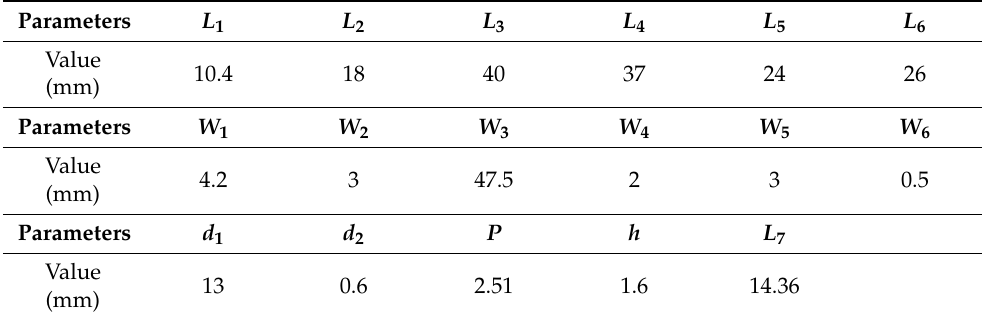
Figure 1. The configuration of the proposed MIMO antenna: ( a ) top view, ( b ) bottom view, and ( c ) side view. Table 1. Dimensions of the proposed MIMO